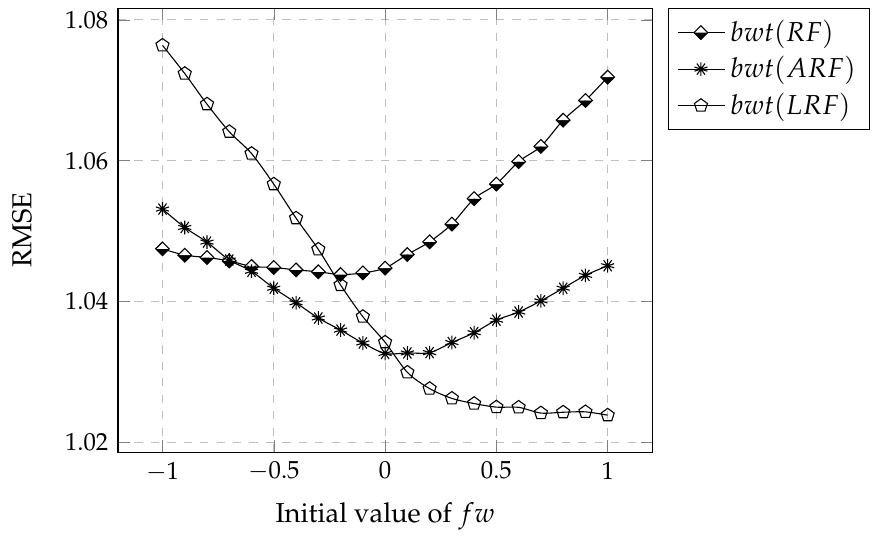
Figure 4. Comparison of MBA’s RMSE for Case B.